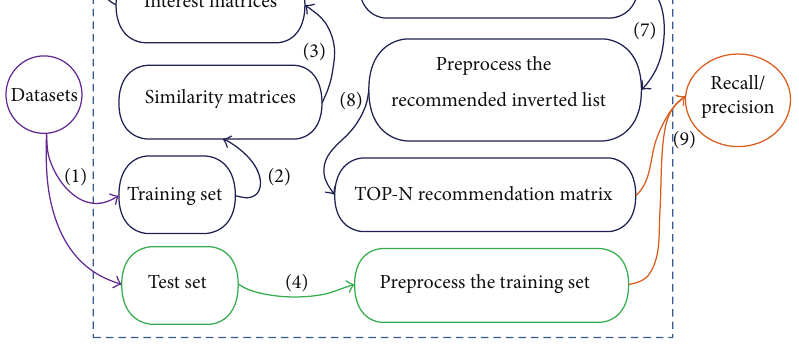
Figure 2: The computing steps of Recall/Precision.